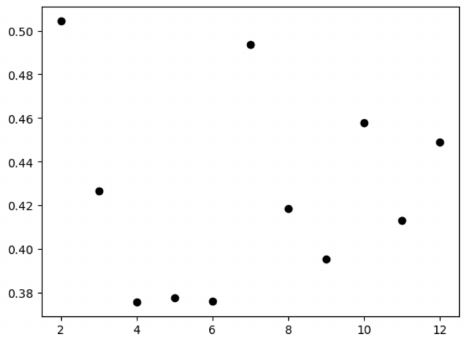
Figure 11. Silhouette coefficient results.